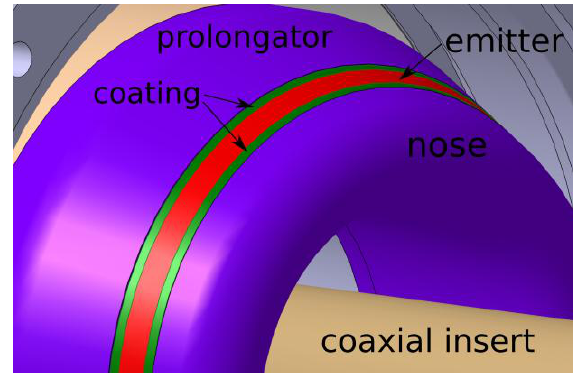
Fig. 6. Cathode of the advanced conventional magnetron injection gun (MIG) with an anti-emissive coating at the emitter edges (indicated in green).